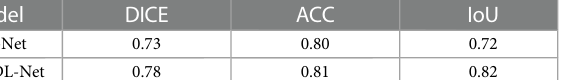
TABLE 4 The corresponding quantitative indexes for white matter segmentation based on different models in the testing cohort. Model